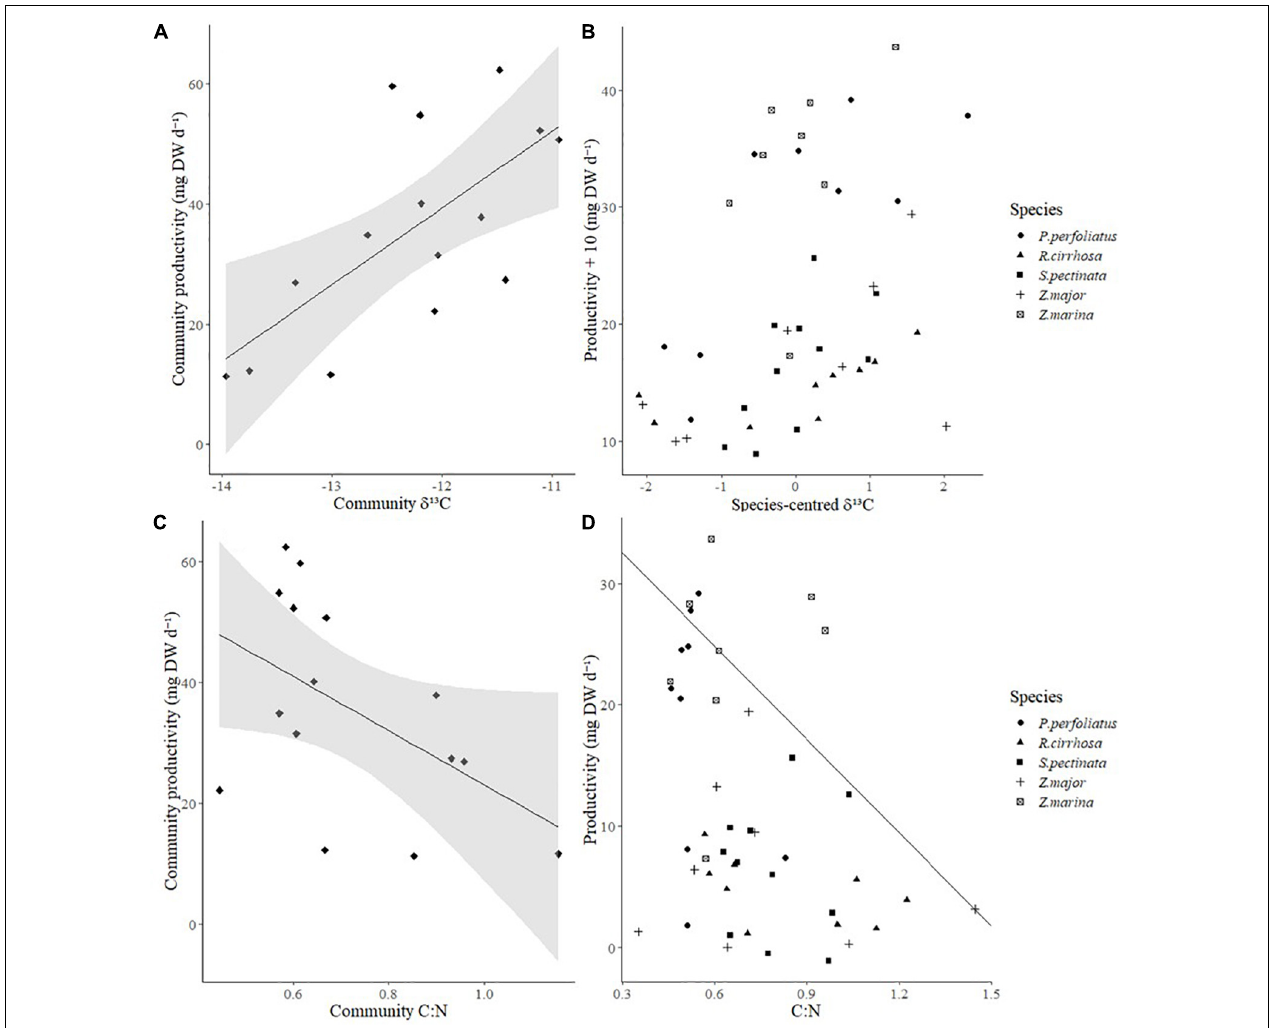
FIGURE 5 | (A) Relationship between community leaf tissue δ 13 C and community productivity (mg DW d − 1 ); solid line: line of best fit, shaded area: 95% confidence intervals. (B) Relationship between species-centered leaf tissue δ 13 C of each species in each community and their productivity (+ 10 in accordance to its entry in a generalized linear model with error family Gamma, mg DW d − 1 ). (C) Relationship between community leaf tissue carbon: nitrogen (C:N) ratios and community productivity (mg DW d − 1 ); solid line: line of best fit, shaded area: 95% confidence intervals. (D) Relationship between leaf tissue C:N of each species in each community and their productivity (mg DW d − 1 ); solid line: 85 th percentile of productivity with changes in